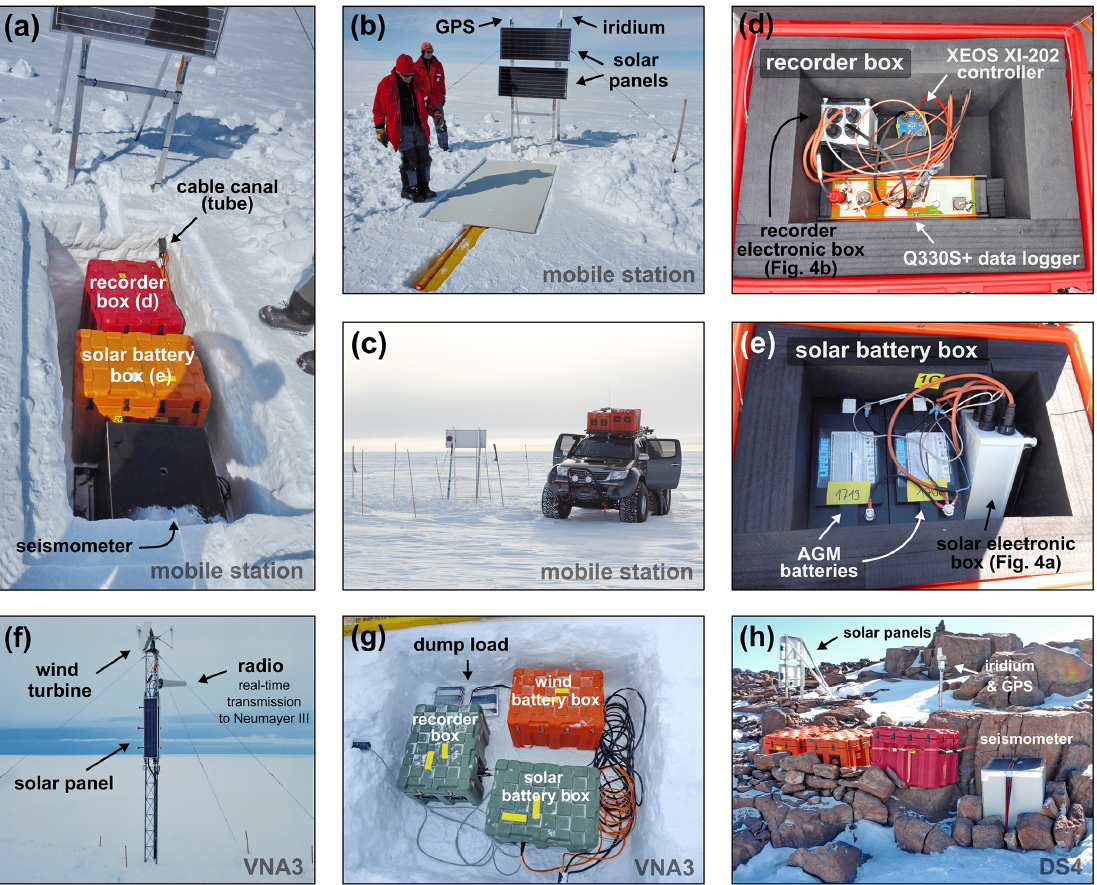
Figure 3. Photographs of the station design from several deployments in western Dronning Maud Land (East Antarctica). Panels (a) – (c) show the setup of the mobile stations on the ice surface. Panels (d) and (e) show the recorder and solar battery boxes from the inside. The permanent real-time station setup of VNA3 is shown in (f) for the ice surface and in (g) for the ice cave. Panel (h) shows the station layout of DS4, which is deployed on a rock base. Photo credits are as follows: (a, b, d–h) Jölund Asseng, (c) Steven